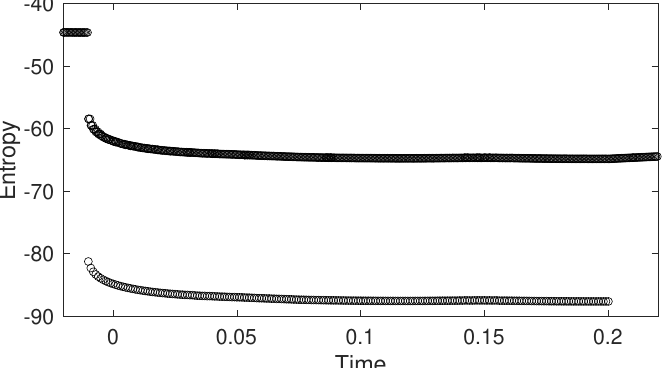
Figure 8. Entropy of sensor suite localization in simulated